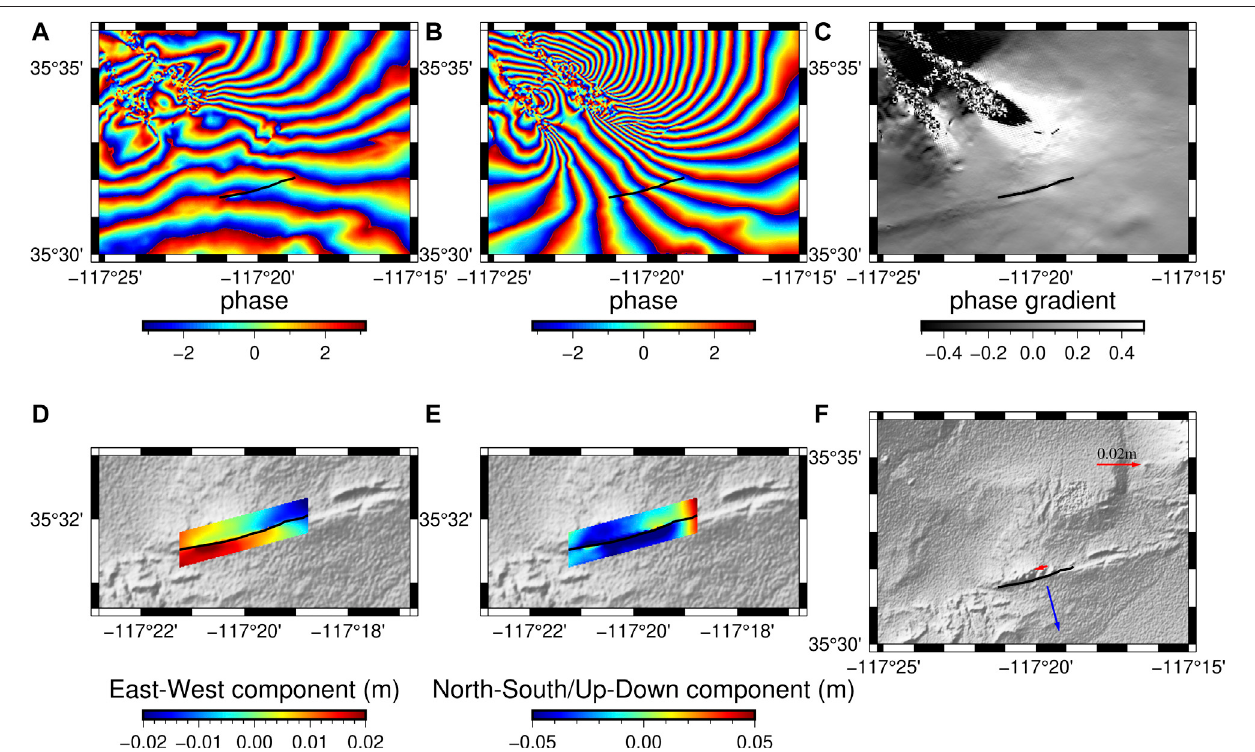
FIGURE6| CoseismicdeformationacrosstheGarlockFault.ThethickblacklineindicatesthesegmentoftheGarlockFaultthatslippedduringthe2019Ridgecrest sequence. Sentinel-1A interferograms of the (A) ascending track (AT64) and (B) descending track (DT71) near the Garlock Fault. The phase gradient map from the descending track (DT71) is shown in (C) . (D) East – west component of displacement near the slipped segment of Garlock Fault, in which red represents slipping toward east, while blue indicates slipping toward west. (E) North – south component of displacement near the slipped segment of Garlock Fault assuming small vertical deformation, in which red represents slipping toward north, while blue indicates slipping toward south. (F) Left-lateral and tensional deformation oftheslipped segment. The red arrow represents the relative slip parallel to the Garlock Fault, and the blue arrow represents the relative motion normal to the Garlock Fault.